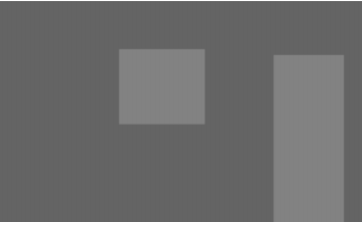
Figure 2. Extraction result of wall. ( a ) Scene segmentation; ( b ) distribution of z coordinate; ( c ) wall partition.